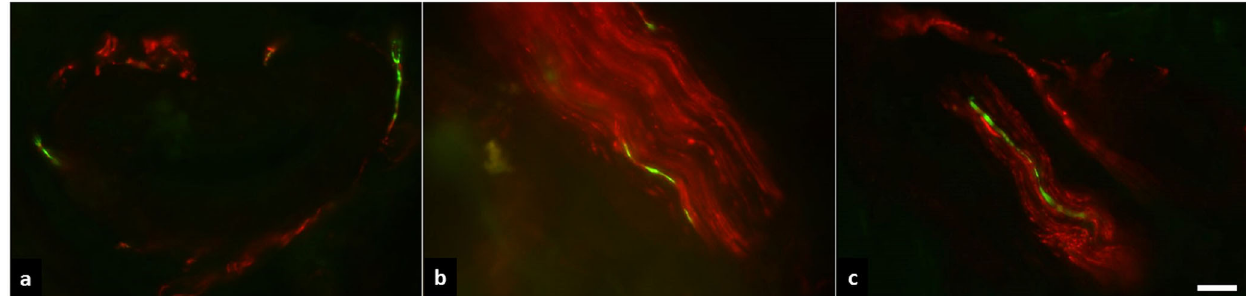
Fig. 4 Phospho- α -Syn deposition in dermal biopsy. Representative photomicrographs of a double-immuno fl uorescence staining with anti- phospho- α -Syn (green) and anti-PGP9.5 (red), Scale bar = 20 µm. Phospho- α -Syn-positive nerve fi bers were found in all three, autonomic vasomotor fi bers ( a ), dermal nerve bundles ( b ), and pilomotor fi bers ( c ) in both biopsies that were taken, from the distal and proximal